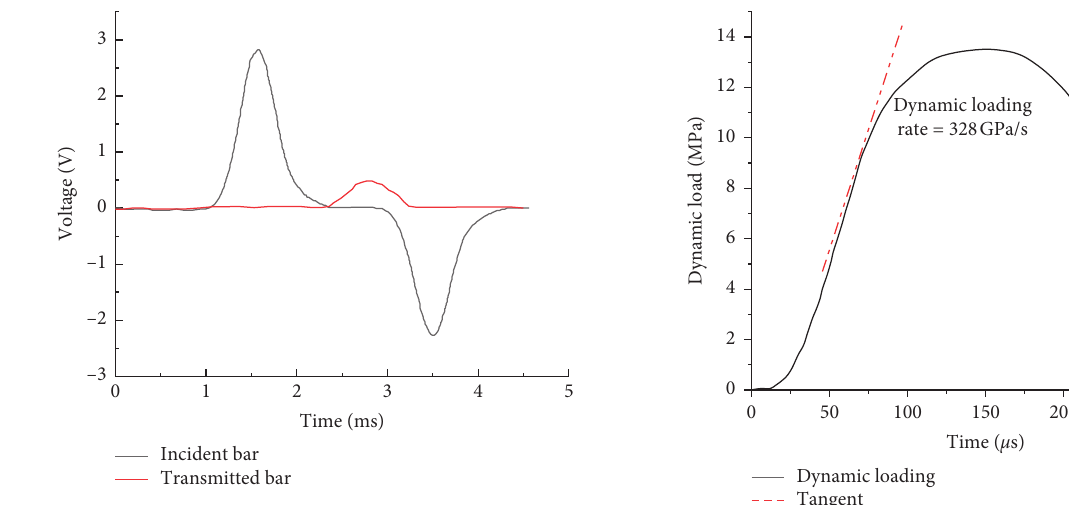
Figure 3: Typical voltage data of the gauges on the incident and transmitted bars.